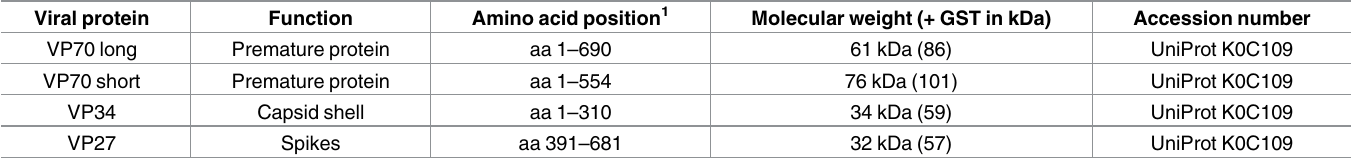
Table 1. Murine astrovirus recombinant capsid